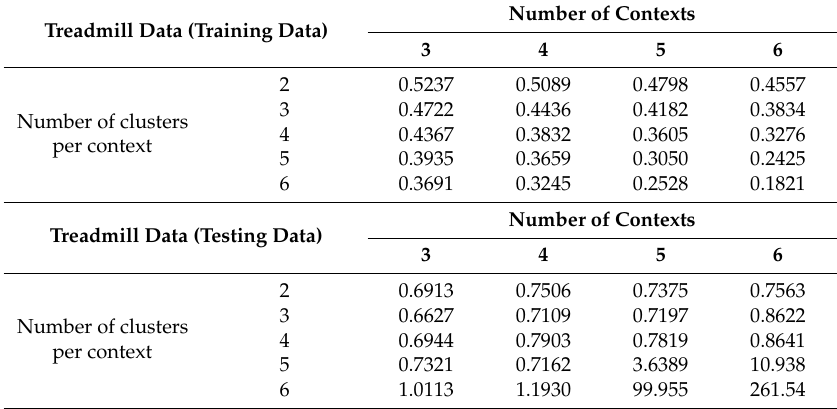
Table 2. RMSE in the incremental RBFNN model for the training and testing datasets.